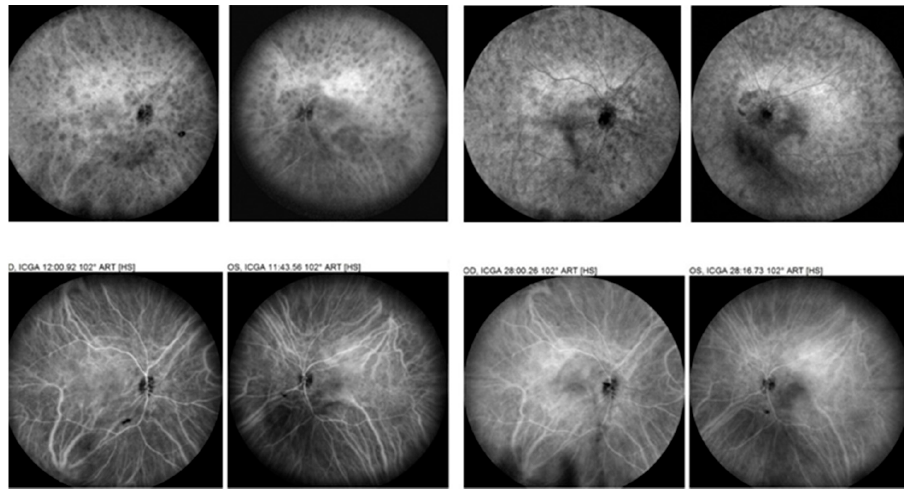
Figure 6. ICGA in HLA-A29 birdshot retinochoroiditis. Most of the stromal lesions are far beyond the field of view of the best OCT-A instruments, giving an excellent global well-defined view of the lesions not obtained